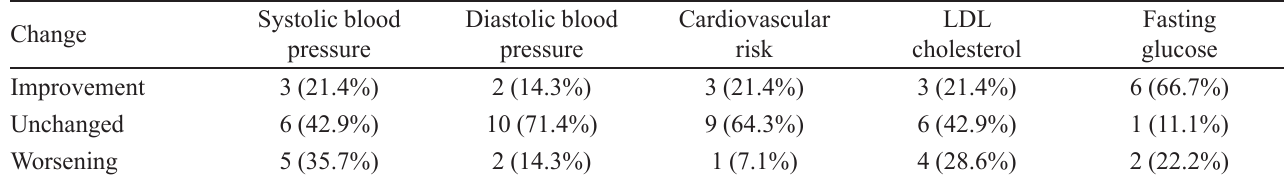
TABLE IV - Changes in the clinical parameters of hypertensive patients receiving care within the Family Health Strategy